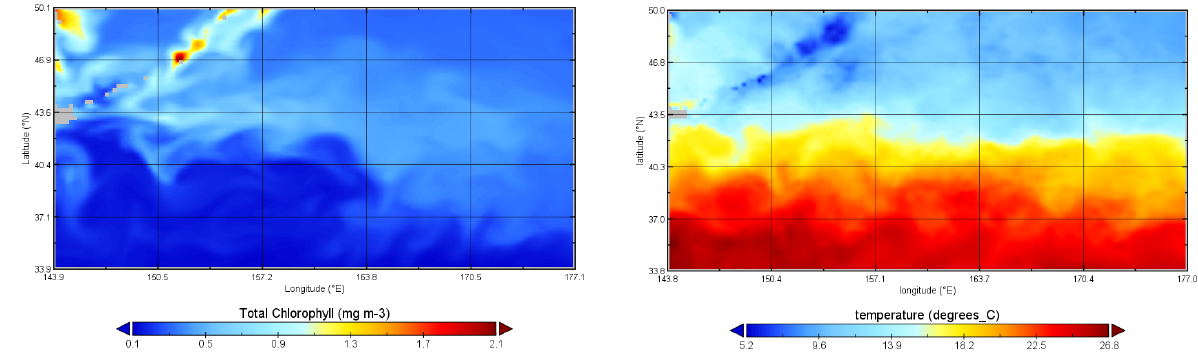
Figure 3. Distribution of Chl α and SST data for a month in the study area.